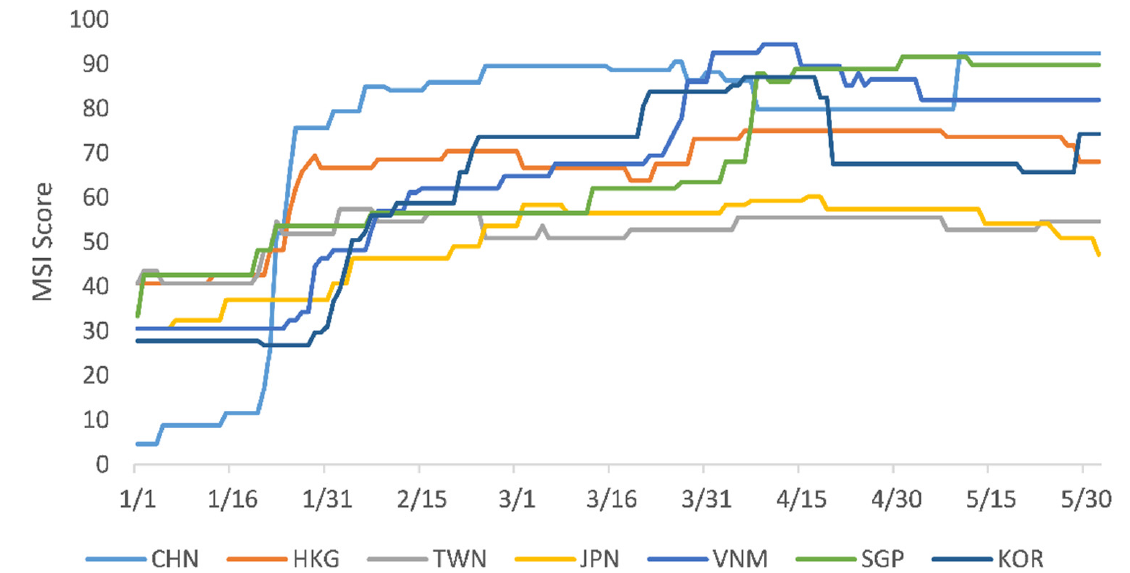
Figure 1. Change in the MSI score in the study sites, 1 January to 30 May 2020. CHN = China, HKG = Hong Kong; JPN = Japan; KOR = South Korea; SGP = Singapore; TWN = Taiwan; VNM = Vietnam. Data sources: ECDC (https://www.ecdc.europa.eu/en/COVID-19/situation-updates (accessed on 1